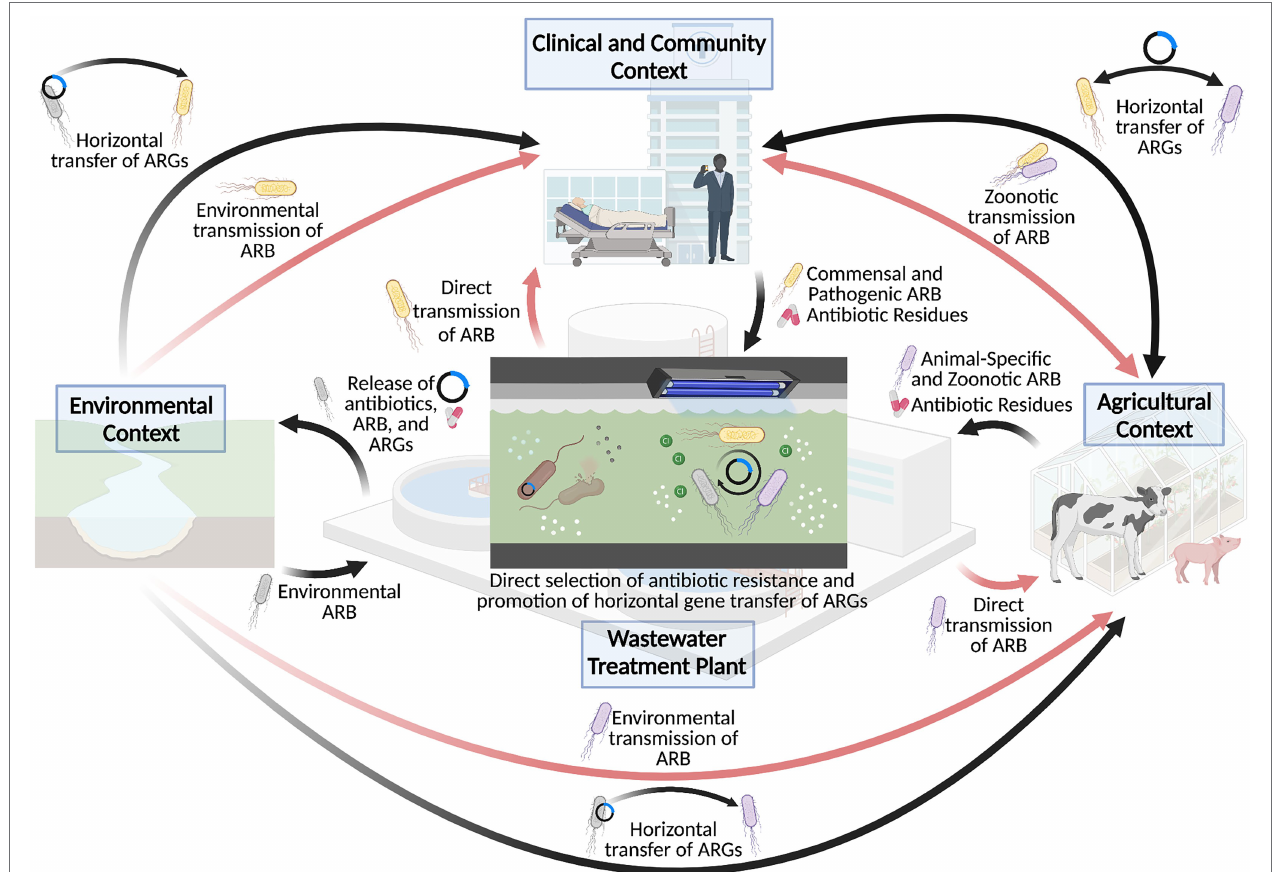
FIGURE 1 | Wastewater treatment plants as a hotspot for the dissemination and selection of antibiotic resistance. Wastewater treatment plants have played an important role in driving the antibiotic resistance crisis, particularly through cycling antibiotics, antibiotic resistant bacteria (ARB) and antibiotic resistance genes (ARG) between clinical, agricultural, and environmental sectors, as depicted by the black arrows. This in turn contributes to the transmission of antibiotic resistant bacteria to human and animal hosts, as shown in the red arrows. Importantly, the conditions of the wastewater treatment plant may also directly contribute to the selection of antibiotic resistance or promote the mobilization of resistance genes within the wastewater matrix, which further exacerbates the antibiotic resistance crisis. Created with